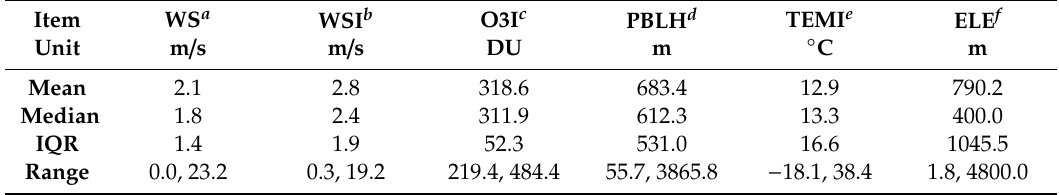
Table 1. Statistics for the measurements and the covariates for the sample data of wind